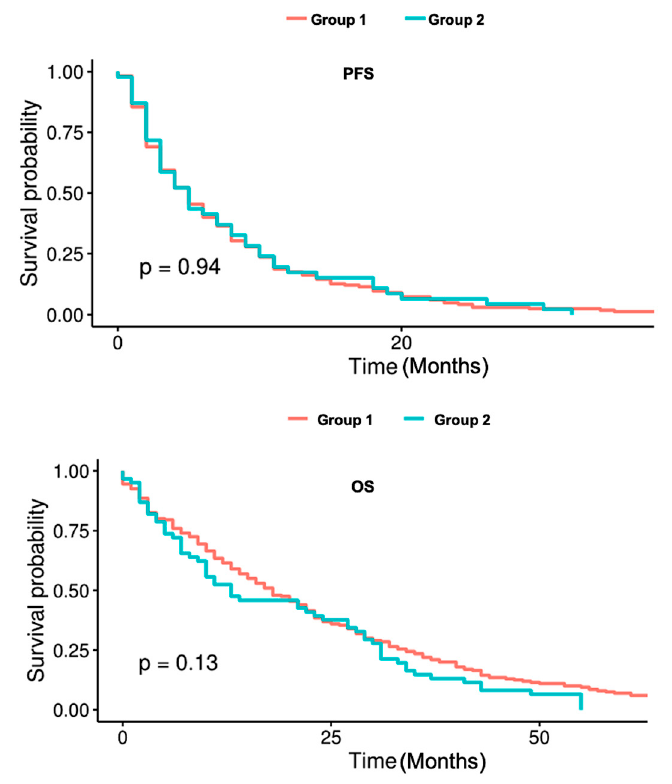
Figure 1. PFS and OS comparison between patients with stable (Group 1) and converted tumor subtype (Group 2). Table 2. Comparing CTC status, CTC count, and PFS and OS between subgroups defined by specific patterns of tumor subtype